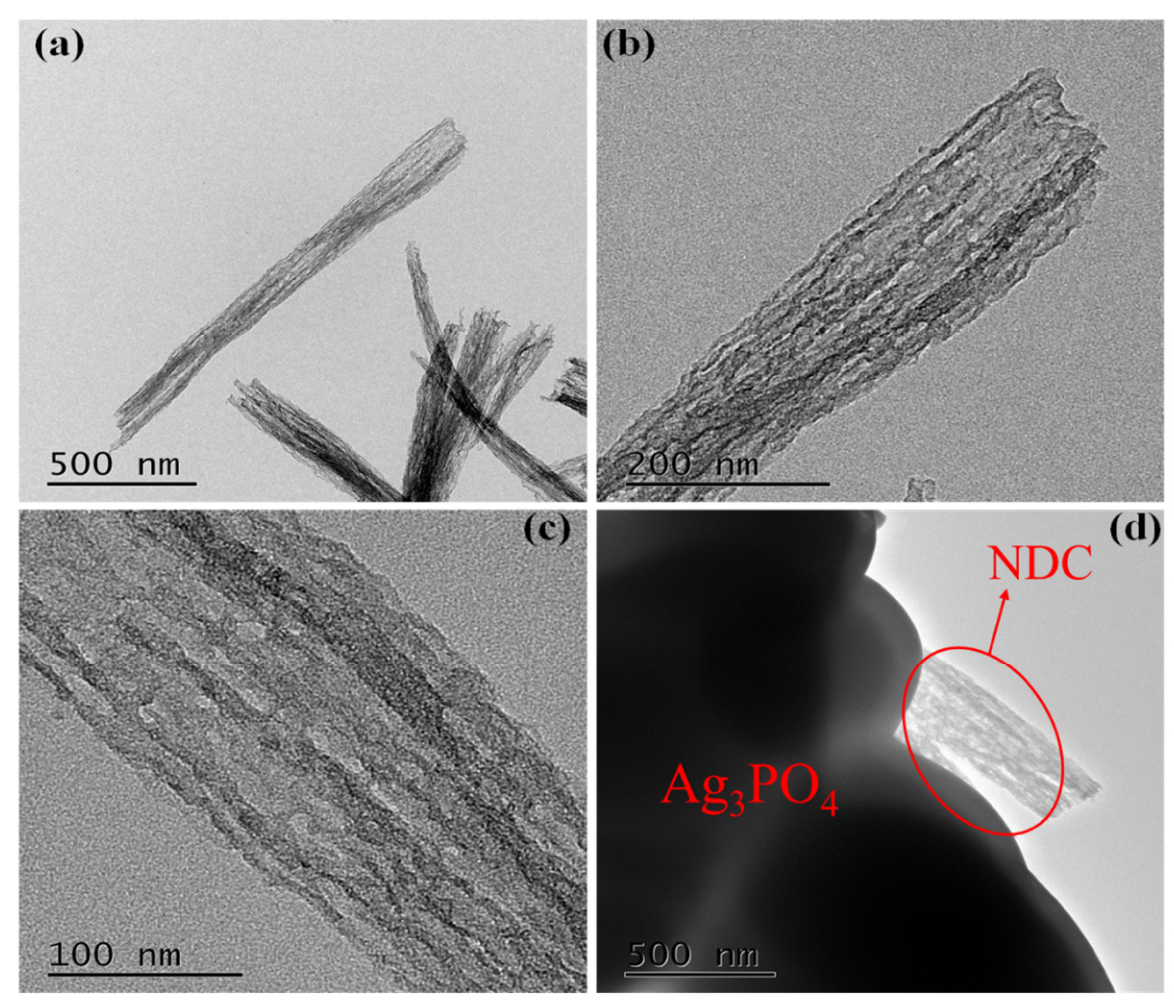
Figure 2. TEM images of NDC at different magnifications ( a – c ) and TEM image of Ag 3 PO 4 @NDC ( d ).